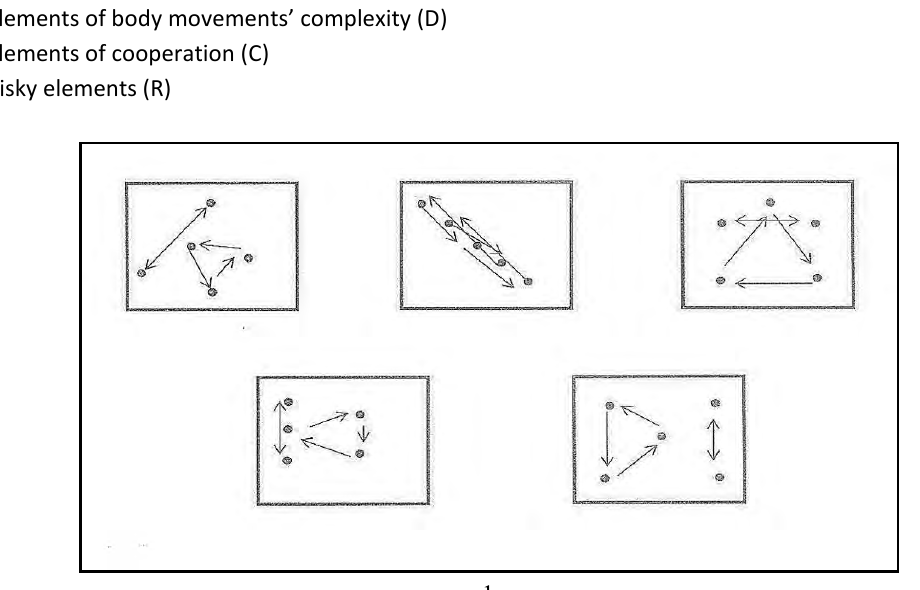
Fig.3. Indicators of time, spent for fulfillment of body movements’ complexity elements (D), cooperation elements (С), risky elements (R), in group exercise with 10 clubs: t – time in seconds; S – team of country; 1 –Spain, 2 –Italy, 3 – Byelorussia, 4 – Russian Federation, 5 –